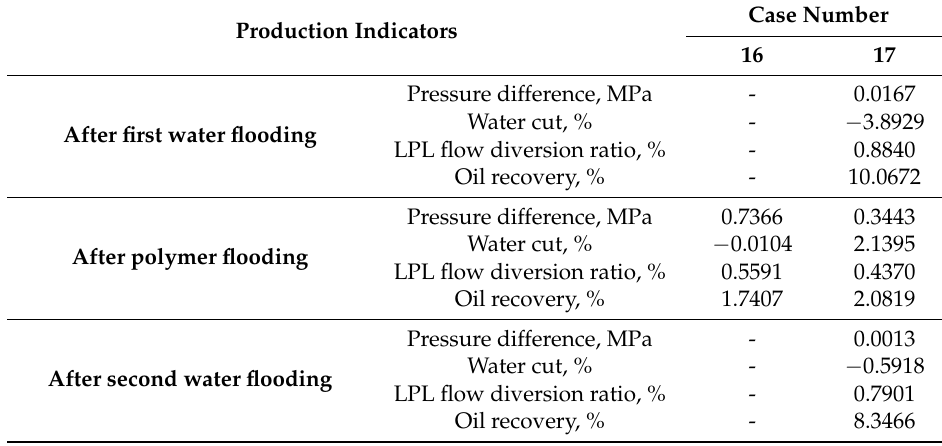
Table 11. Production indicator reductions of Case 16 vs. Case 3, and those of Case 17 vs. Case